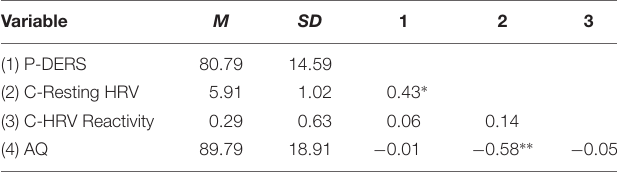
TABLE 1 | Means, standard deviations, and correlations among studied variables.